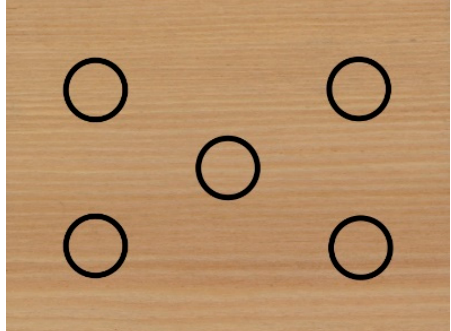
Figure 2. Template used to ensure that locations of colour measurements on samples was the same at each exposure interval—measuring area was given using d /8 mm geometry of spectrophotometer.